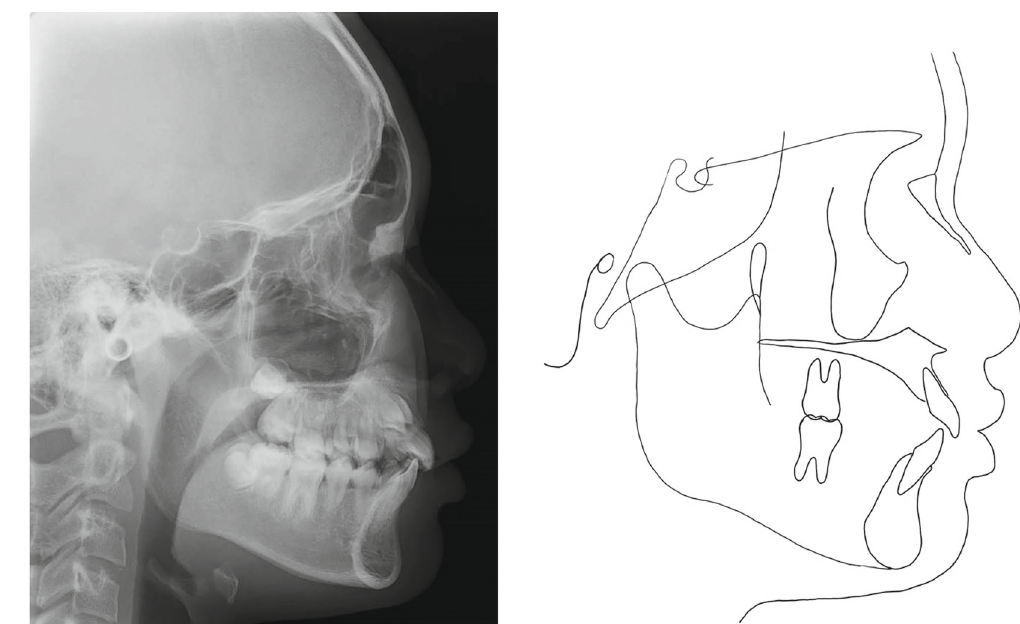
Figure 2: Pretreatment lateral cephalometric radiograph and cephalometric